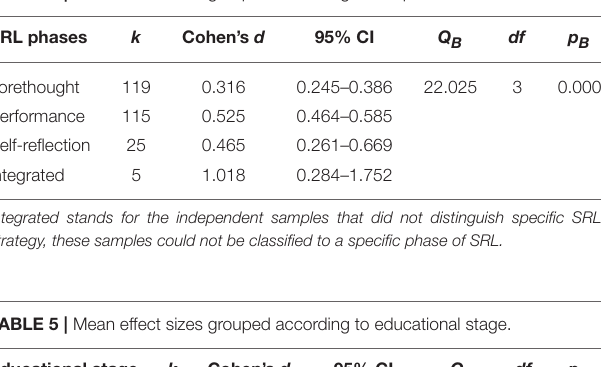
TABLE 2 | Mean effect sizes of SRL strategies. TABLE 4 | Mean effect sizes grouped according to the phases of SRL.